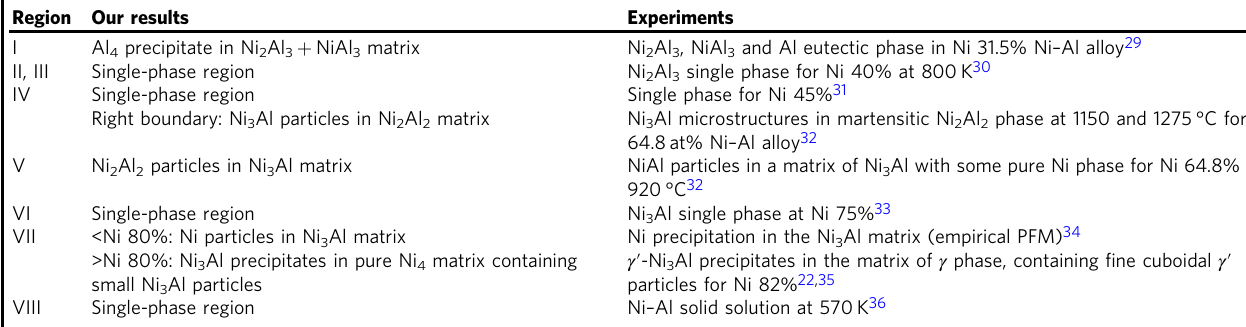
Table 1 Summary of the resulting microstructures/phases for various regions in the phase diagram Region Our